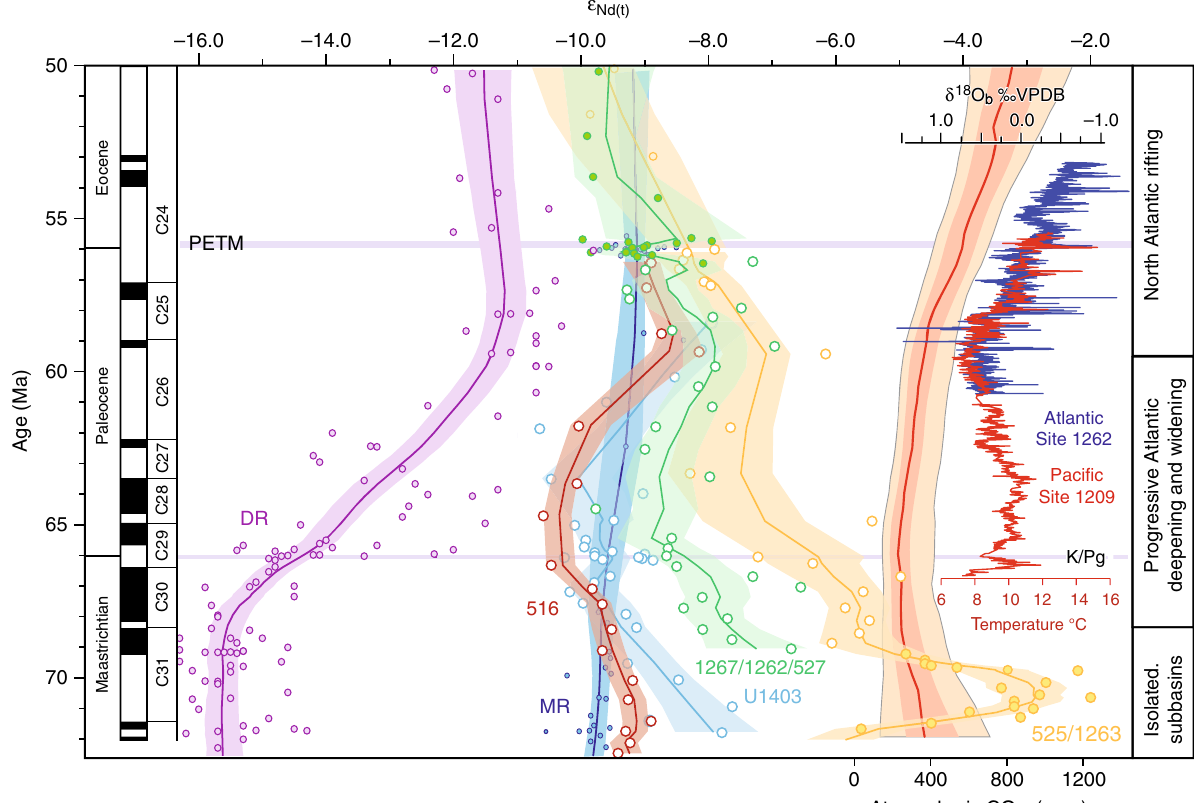
Fig. 4 The convergence of Nd-isotope values. Maastrichtian to early Eocene Nd-isotope records compared to atmospheric CO 2 levels and deep-sea temperature evolution. Open symbols depict new ε Nd( t ) data for North Atlantic Site U1403 (Newfoundland margin, dark blue) and South Atlantic Sites 516 (Rio Grande Rise, red), 1267 (northern fl ank of the Walvis Ridge, green) and 525 (top of the Walvis Ridge, yellow). Filled symbols depict selected high- resolution ε Nd( t ) data from Demerara Rise in the North Atlantic 26,28 (purple), Sites 527 33 and 1262 34 on the fl ank of the Walvis Ridge (green), Site 1263 34 and Site 525 22 on the Walvis Ridge (yellow), and Maud Rise in the Southern Ocean 20 (dark blue). The ε Nd(t) data have been smoothed by LOWESS regression ( f = 0.3) with the shaded areas representing the 97.5% con fi dence interval. The ε Nd( t ) data are fl anked by the geomagnetic polarity time scale on the left and on the right by reconstructed atmospheric CO 2 levels 11 , benthic oxygen isotope data from the Paci fi c 41 and the Atlantic 13 , and the suggested evolution of the Atlantic Ocean. The Paleogene age model of the Sites rests on a combination of magnetic and nannofossil stratigraphy plotted against the GTS 2012 64 . C31-C24: paleomagnetic chrons, δ 18 O b : oxygen isotope ratio from benthic foraminifera, VPDB: Vienna Pee Dee Belemnite standard, PETM: Paleocene/Eocene Thermal Maximum, DR: Demerara Rise, K/Pg: Cretaceous/Paleogene boundary, MR: Maud